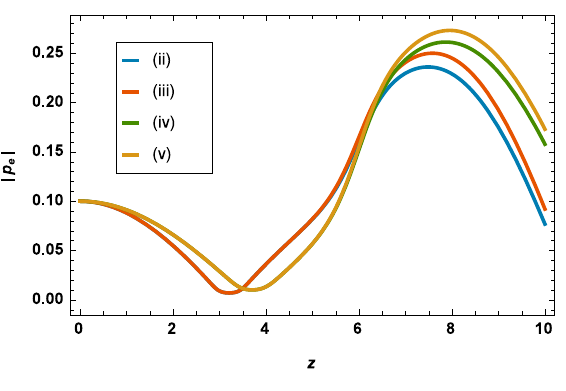
Fig. 8 Pressure along Constricted Tube for Various Pressure-Radius Relations with λ a = 0 . 75 , α = 15 , β = 0 . 5